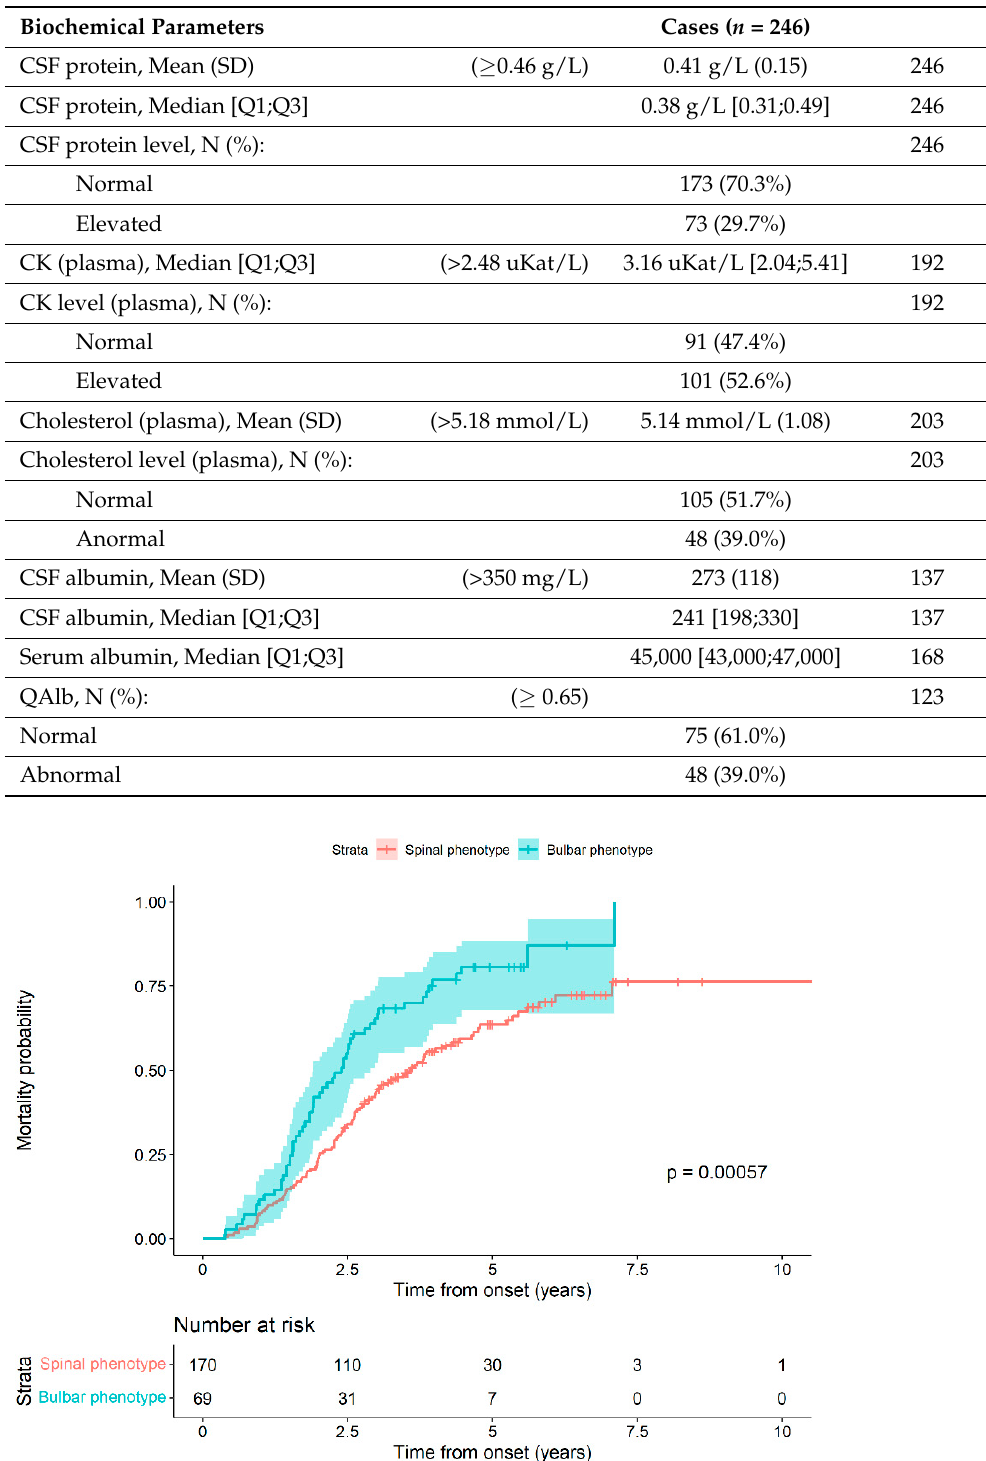
Table 2. Biochemical analysis data for CSF and plasma from ALS patients.